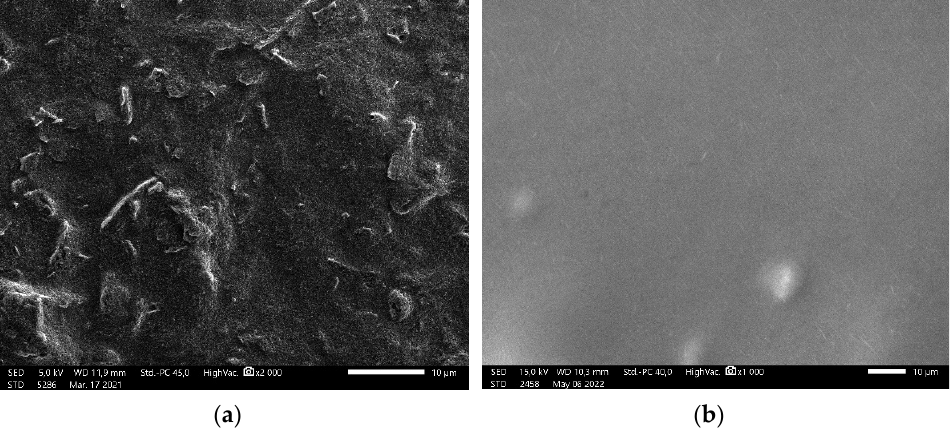
Figure 1. SEM images of sensor surface: ( a ) graphene modified; ( b ) PVC membrane.